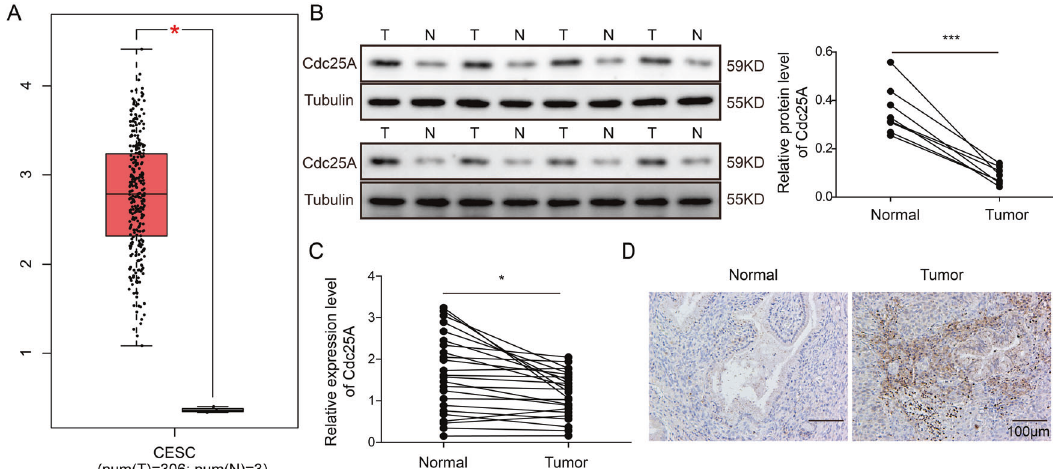
Fig. 1 Cdc25A was elevated in human cervical cancer tissues. A Cdc25A levels in cervical cancer tissues and normal cervical tissues from the TCGA dataset. B Cdc25A protein levels in human cervical cancer tissues and adjacent non-tumour tissues from eight cervical cancer patients. C Cdc25A mRNA levels in human cervical cancer tissues and adjacent non-tumour tissues from cervical cancer patients ( N = 24). D IHC analysis of Cdc25A levels in human cervical cancer tissues and adjacent non-tumour tissues from cervical cancer patients. Each experiment was repeated three times. * P < 0.05; *** P <